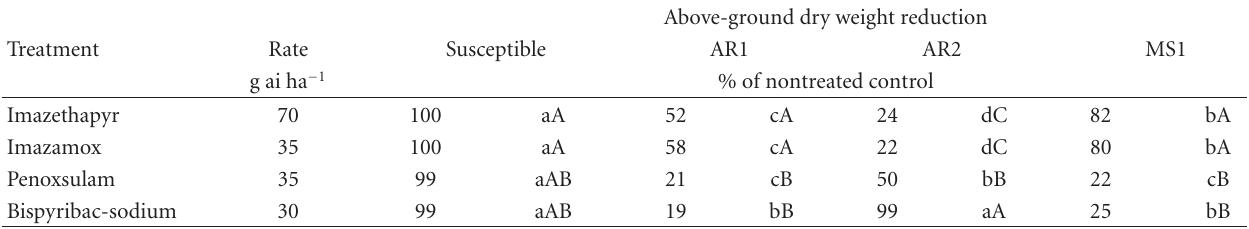
a Means for each population within a column followed by the same uppercase letters and means for each herbicide within a row followed by the same lowercase letters are not significantly di ff erent according to Fisher’s protected LSD test ( α = 0 . 05).